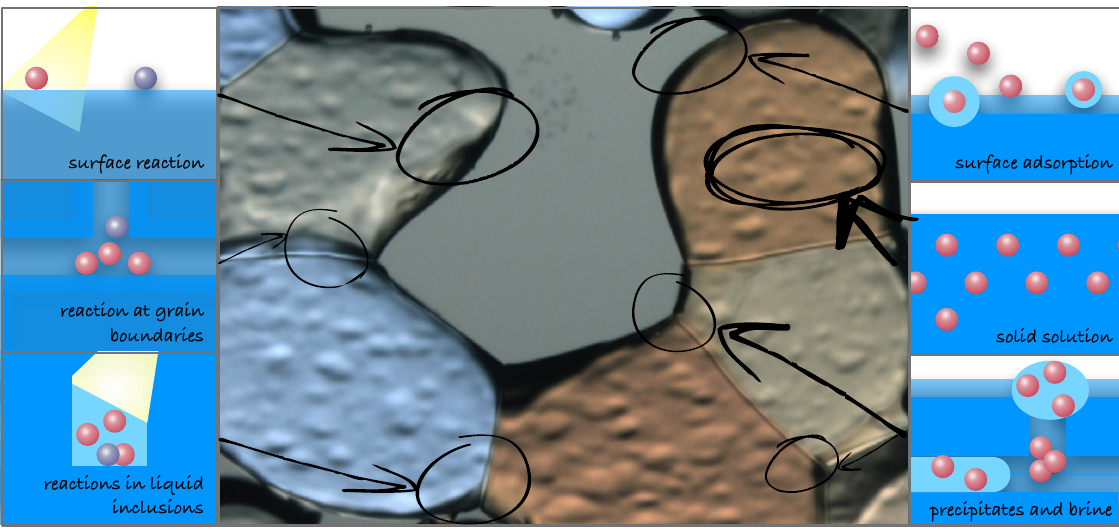
Fig. 1. Illustration of the multiple domains in snow hosting impurities and reactions. The photo shows a ≈ 1mm-wide picture of a thin section of alpine snow as seen under a polarised microscope. Ice crystals appear coloured, interstitial air greyish (courtesy of F. Riche and M. Schneebeli, copyright by WSL SLF Davos). The schemes illustrate impurities (red and blue spheres) and their location within the individual compartments in snow – in bulk ice (dark blue) and on its surface, interstitial air (white) and liquid brine (light blue). The disordered interface at the ice crystal’s surface and its potential heterogeneity given by hydration shells surrounding impurities are illustrated as grey-bluish and light-blue areas. On the left, locations where reactions occur are sketched (top to bottom): heterogeneous (photo)reactions, (bi-molecular) reactions in grain boundaries, (photo)reactions in liquid micro-inclusions. In the right panel the different compartments are illustrated: impurities at the disordered ice surface with varying hydration shell in their vicinity, ordered arrangement of impurities in the ice crystal as solid solution, and solid precipitates and liquid brine in grain boundaries and